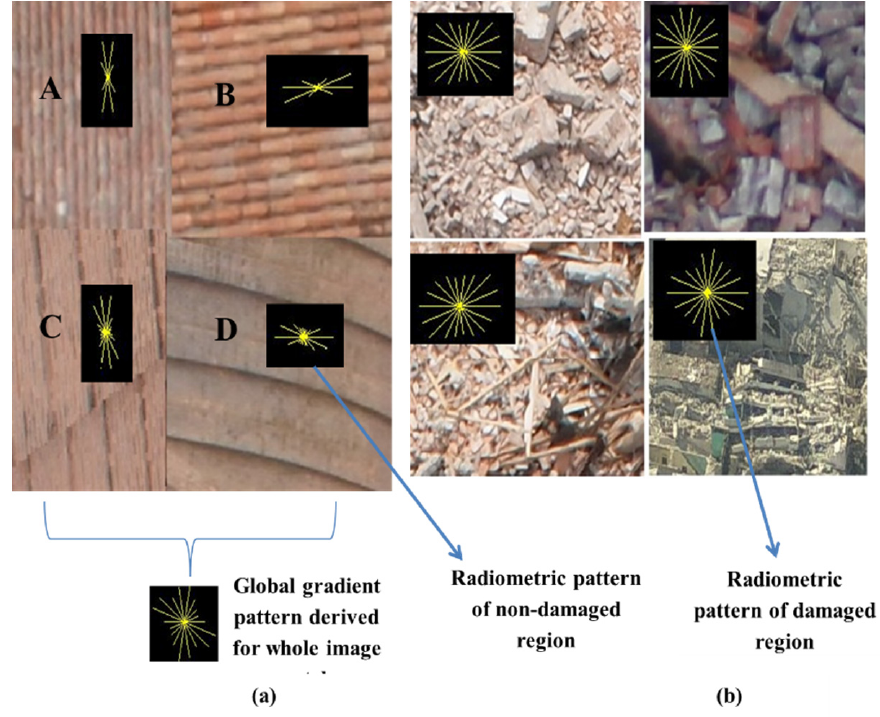
Figure 8. ( a ) Local and global gradient pattern of an image patch that contains four objects with different dominant orientations; ( b ) gradient pattern of damaged regions.